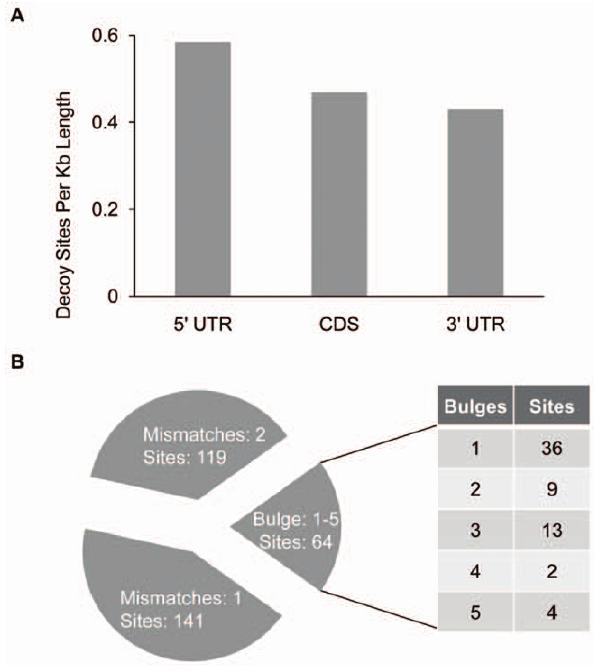
Figure 7. Computational prediction of endogenous miRNA decoys in Arabidopsis. ( A ) Distribution of predicted decoy sites in 5 9 UTR, CDS and 3 9 UTR of 286 protein-coding transcripts. If a decoy site spans two regions, i.e., 5 9 UTR – CDS or CDS – 3 9 UTR, the decoy site is assigned to the region in which the majority of the site is contained. The length of the 5 9 UTR, CDS, and 3 9 UTR of 286 transcripts is tallied respectively, and then the number of decoy sites for each feature is normalized to 1 kb sequence length. ( B ) Predicted decoy sites are classified into the ‘bulge’ type if there are bulges corresponding to miRNA bases 10–11, otherwise, they are classified into the ‘mismatch’ type, decoys of which have at least one mismatch to miRNA base 10 or 11.